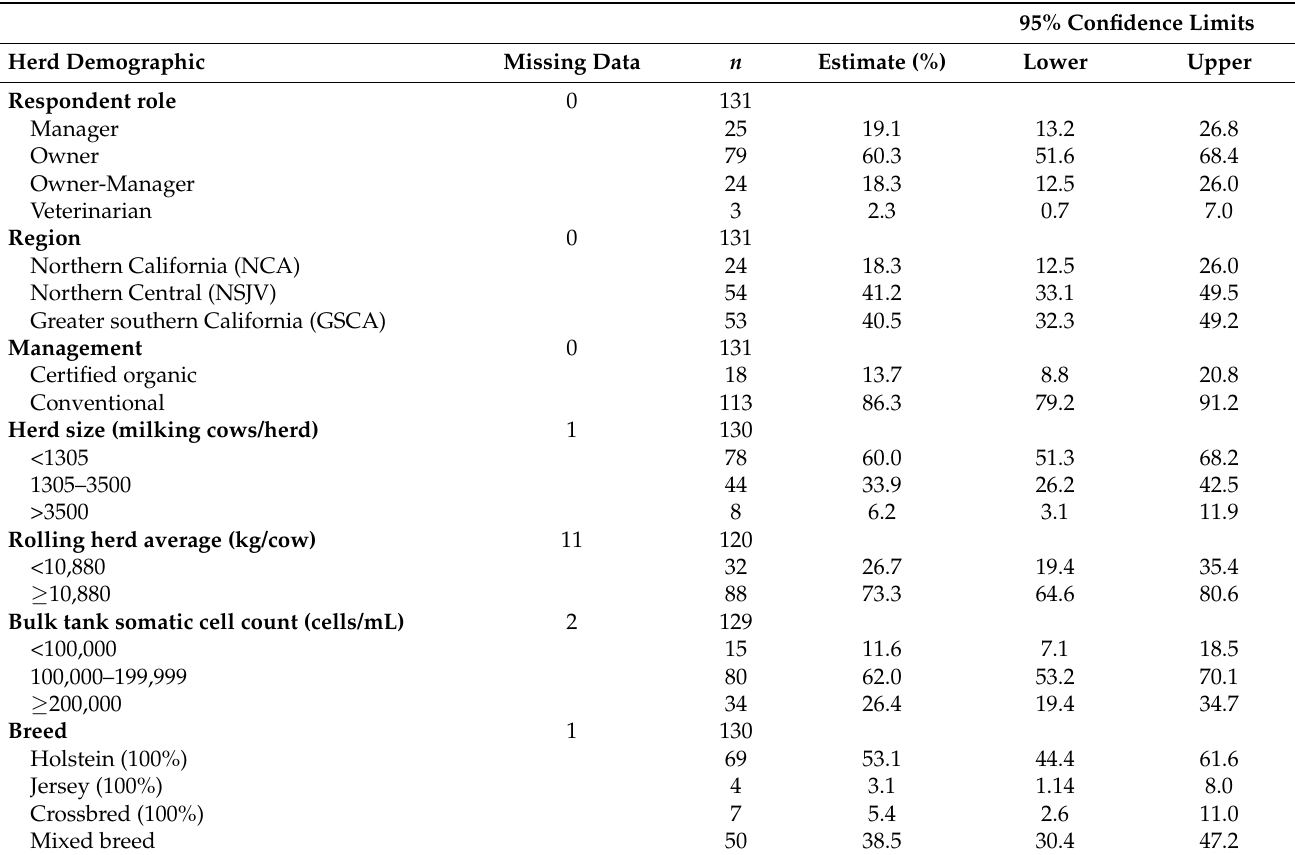
Figure 2. Summary of returned and completed surveys on antimicrobial drug use in adult cows mailed in 2019 to 1282 licensed grade A California’ dairies. Table 1. Summary of herd information from responses to a mailed questionnaire on antimicrobial drug (AMD) use in adult cows on California dairies during